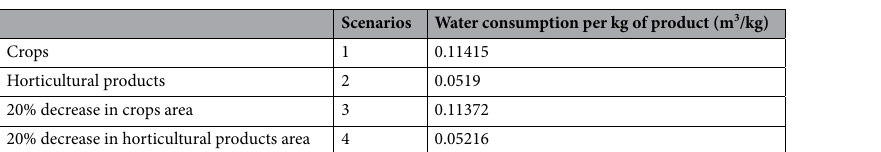
Table 5. The numerical value of the selected index in the Zaayandeh-Rud